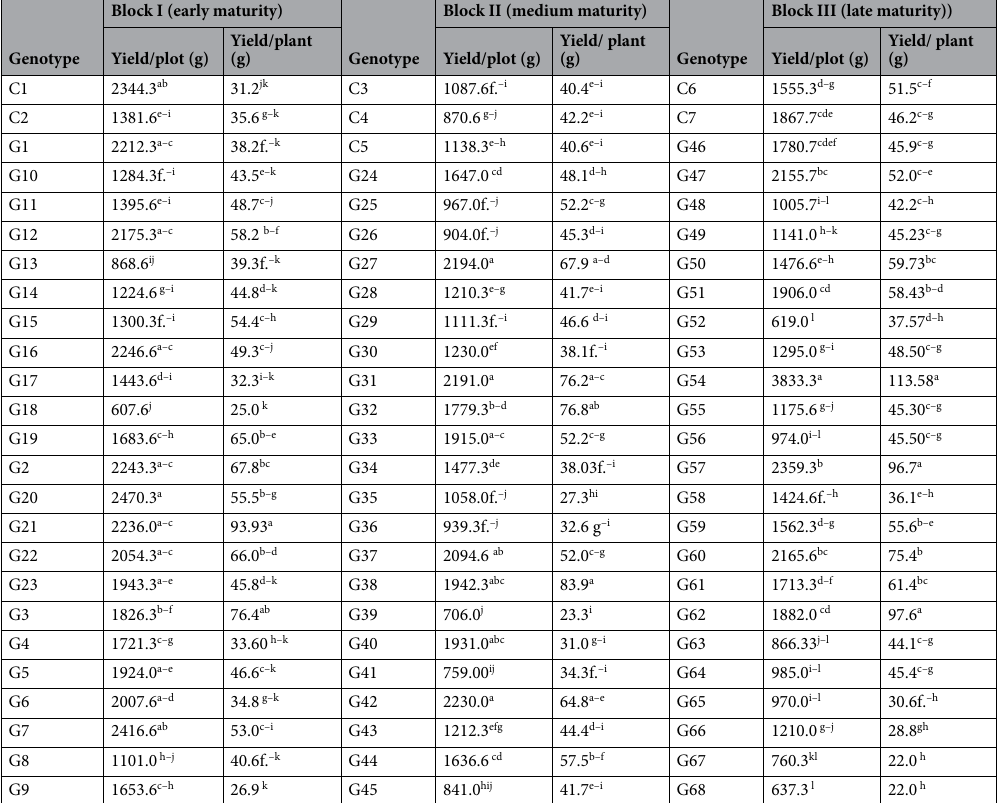
Table 2. Pair wise comparison of the advanced breeding lines within early, medium and late maturity groups. Pairwise comparison using LSD ( p <